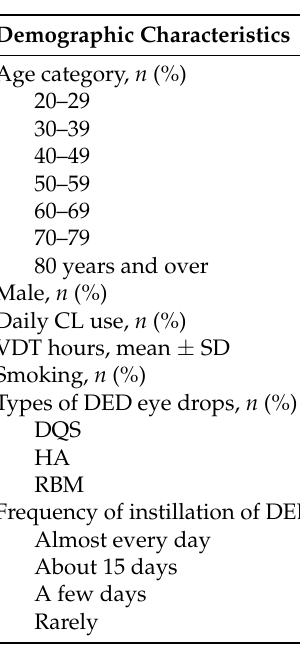
Table 1. Background characteristics of the